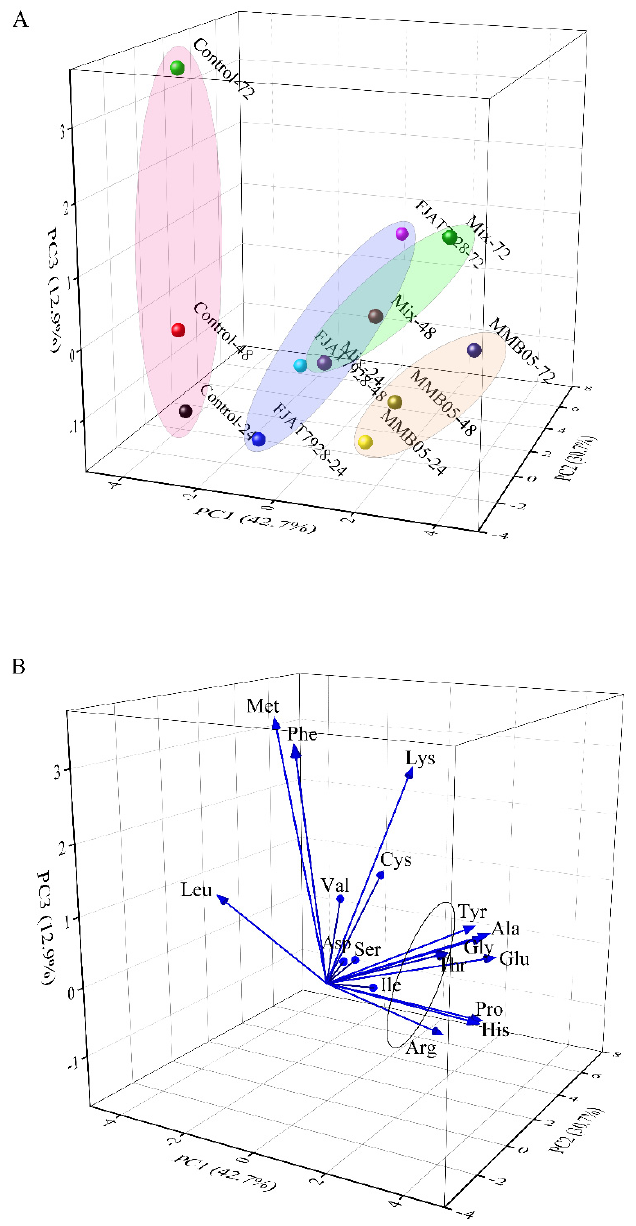
Figure 8. Principal component diagram of free amino acid content changes during LAB stains fermentation of P. yezoensis sauce. score plot ( A ); loading plot ( B ).